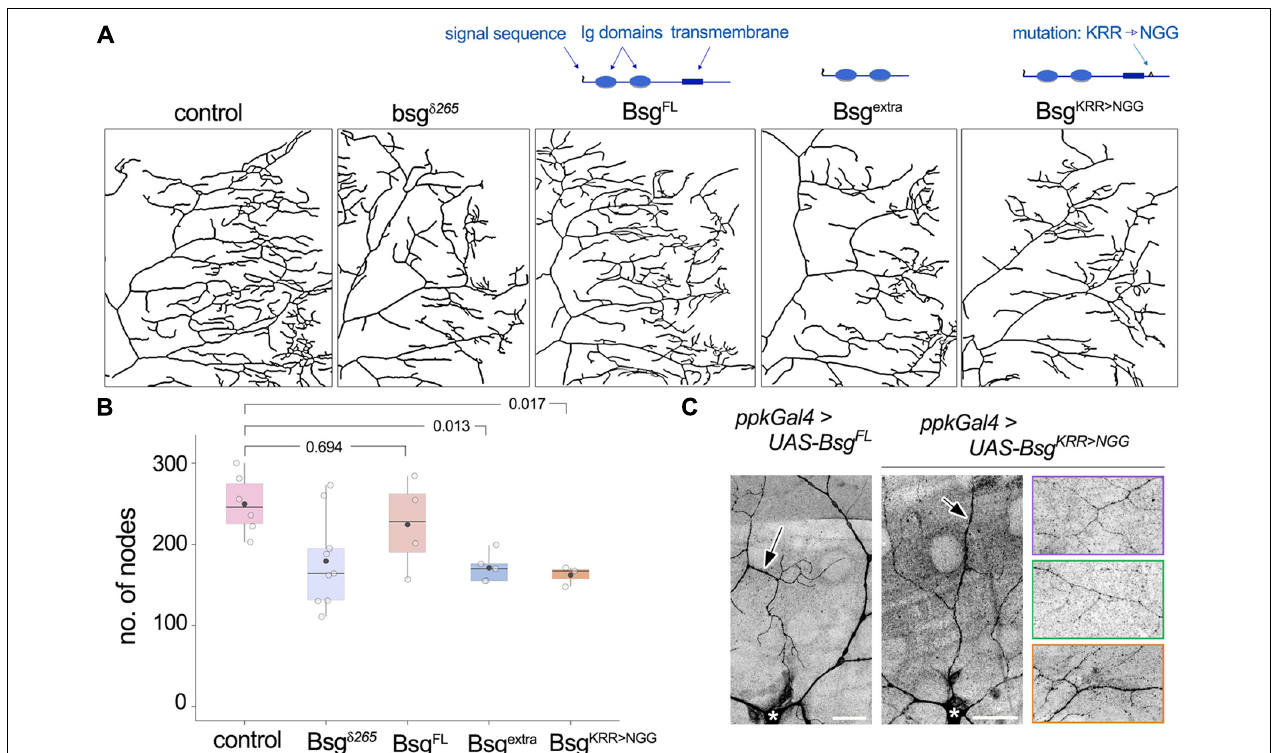
FIGURE 6 | Structure-function analysis of Basigin in dendrite morphogenesis. (A) Dendrite traces of posterodorsal quadrants of class IV neurons under control, mutant, and various rescue conditions. Schematics indicate functional domains in full-length Basigin (Bsg FL ), a truncated variant containing only the extracellular Ig domains (Bsg extra ), and a mutant variant with the KRR motif in the intracellular region changed to NGG (Bsg KRR > NGG ). Bsg FL rescued the reduction in branching observed in bsg - / - MARCM clones of class IV neurons (A,B) . Neither Bsg extra nor Bsg KRR > NGG was able to rescue, indicating that membrane-tethering and integrity of the intracellular KRR motif are essential for Basigin function (A,B) . (C) GFP-tagged Bsg FL and Bsg KRR > NGG both showed strong localization to class IV dendrites when expressed under the ppk-Gal4 driver. Arrows indicate GFP signal in dendrites and * indicates cell body of the class IV neuron ddaC. Rightmost images showcase localization of Bsg KRR > NGG ::GFP to fine terminal branches of class IV neurons. Each colored panel is from a different animal. p values are indicated for Tukey’s HSD following one-way ANOVA ( p = 0.0058) (B) . Scale bars, 25 µ